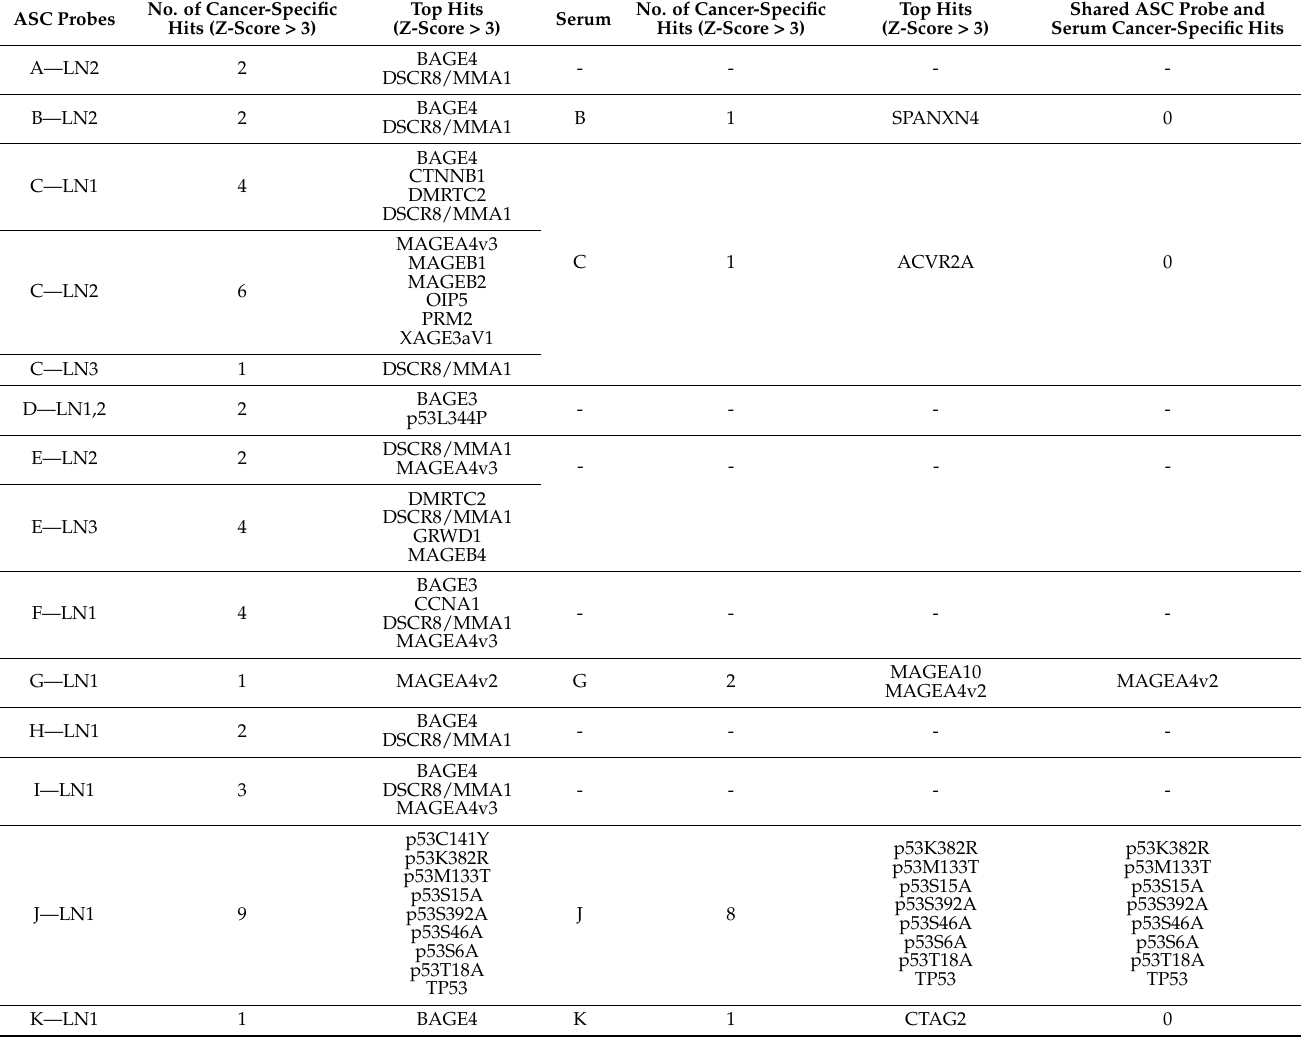
Table 3. Antigen reactivities identified with ovarian cancer cohort 1 using Sengenics CTA protein arrays. Ovarian cancer ASC probes ( n = 11, A–K) and selected matched sera ( n = 5) were screened using Sengenics CTA protein arrays. ASC